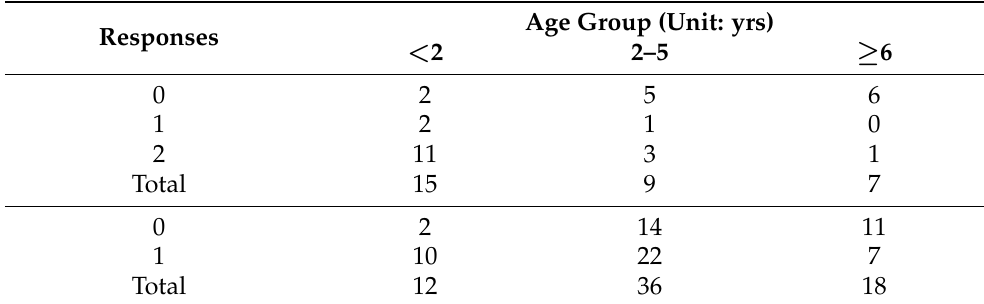
Table 1. OME status of Amoxicillin